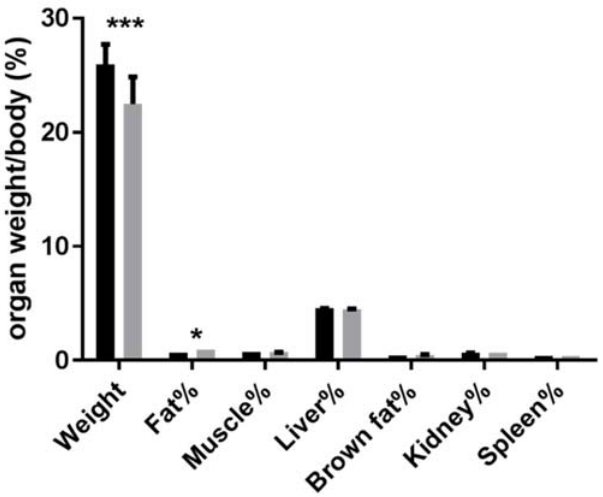
Figure 1. Organ mass/body mass rate of mice. * p < 0.05, *** p < 0.001 vs. chow. Fat: epididymal adipose tissue weight; muscle: gastrocnemius muscle tissue. Brown fat: brown adipose tissue. Fat, muscle and kidney were average of bilateral organ or tissue weight.